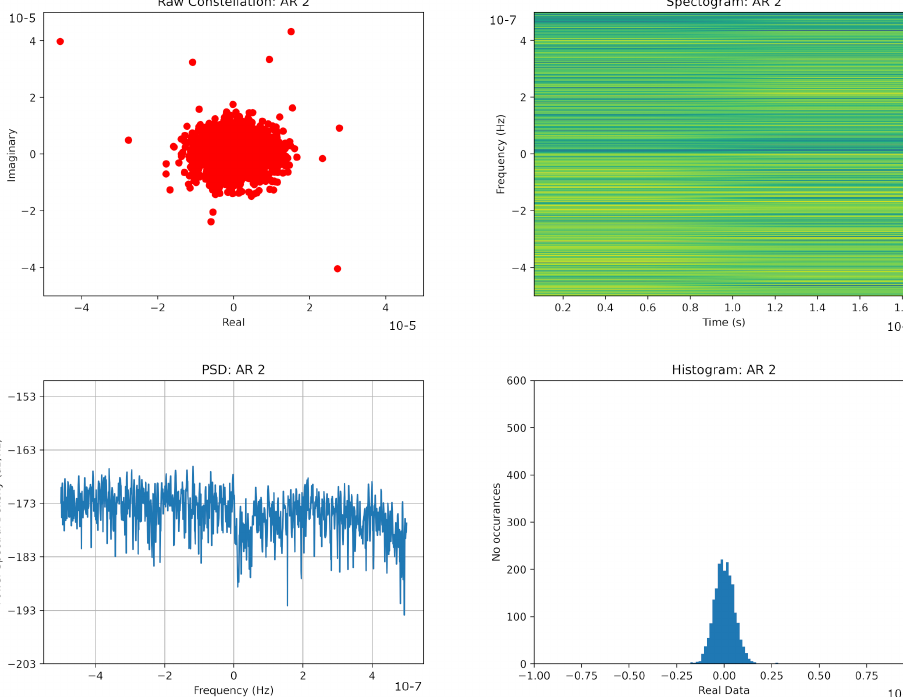
Figure 8. AR Mode 1—switched on.